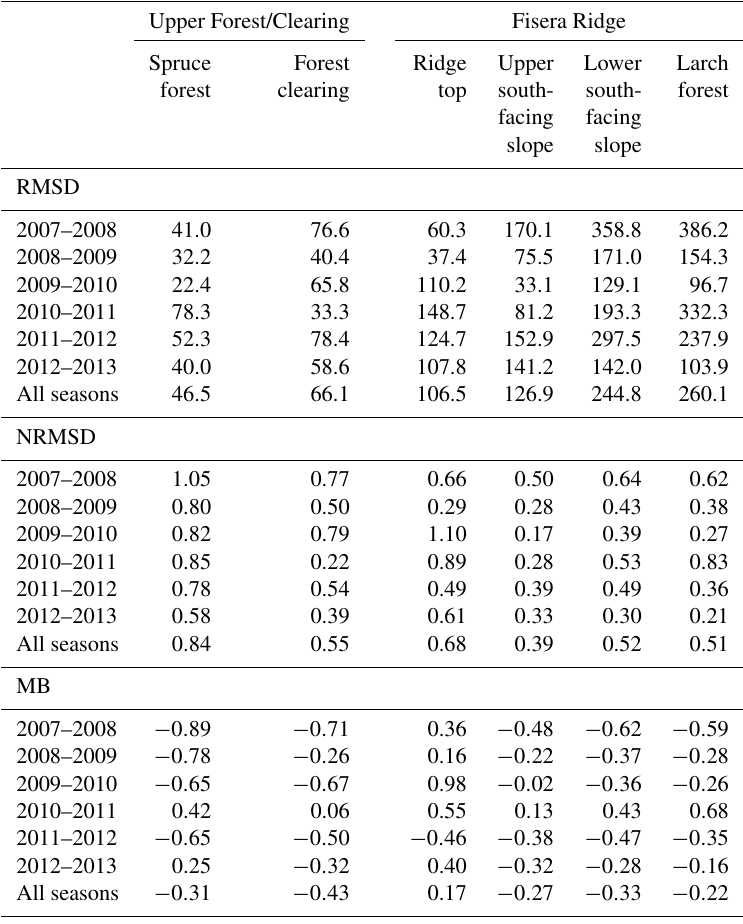
Table 3. Evaluation of simulated snow accumulation using the RMSD (mm SWE), normalised RMSD (NRMSD), and model bias (MB) at the Upper Forest/Clearing and Fisera Ridge sites, Marmot Creek Research Basin.